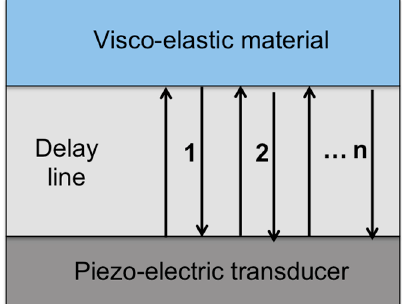
Figure 6. Acoustic measurement of the complex shear modulus of a viscoelastic material. A short pulse is sent from a shear wave piezo-electric transducer through a delay line. The storage and loss moduli can be deduced from the amplitude and arrival time of the n e echo compared to the reference.